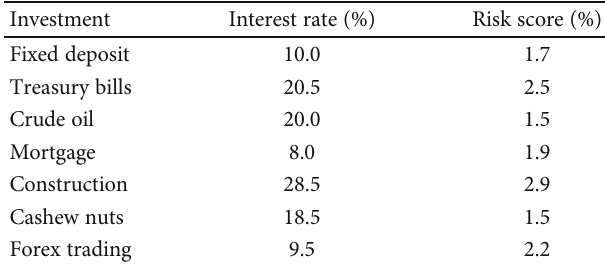
Table 1: Investment areas, interest rates, and risk